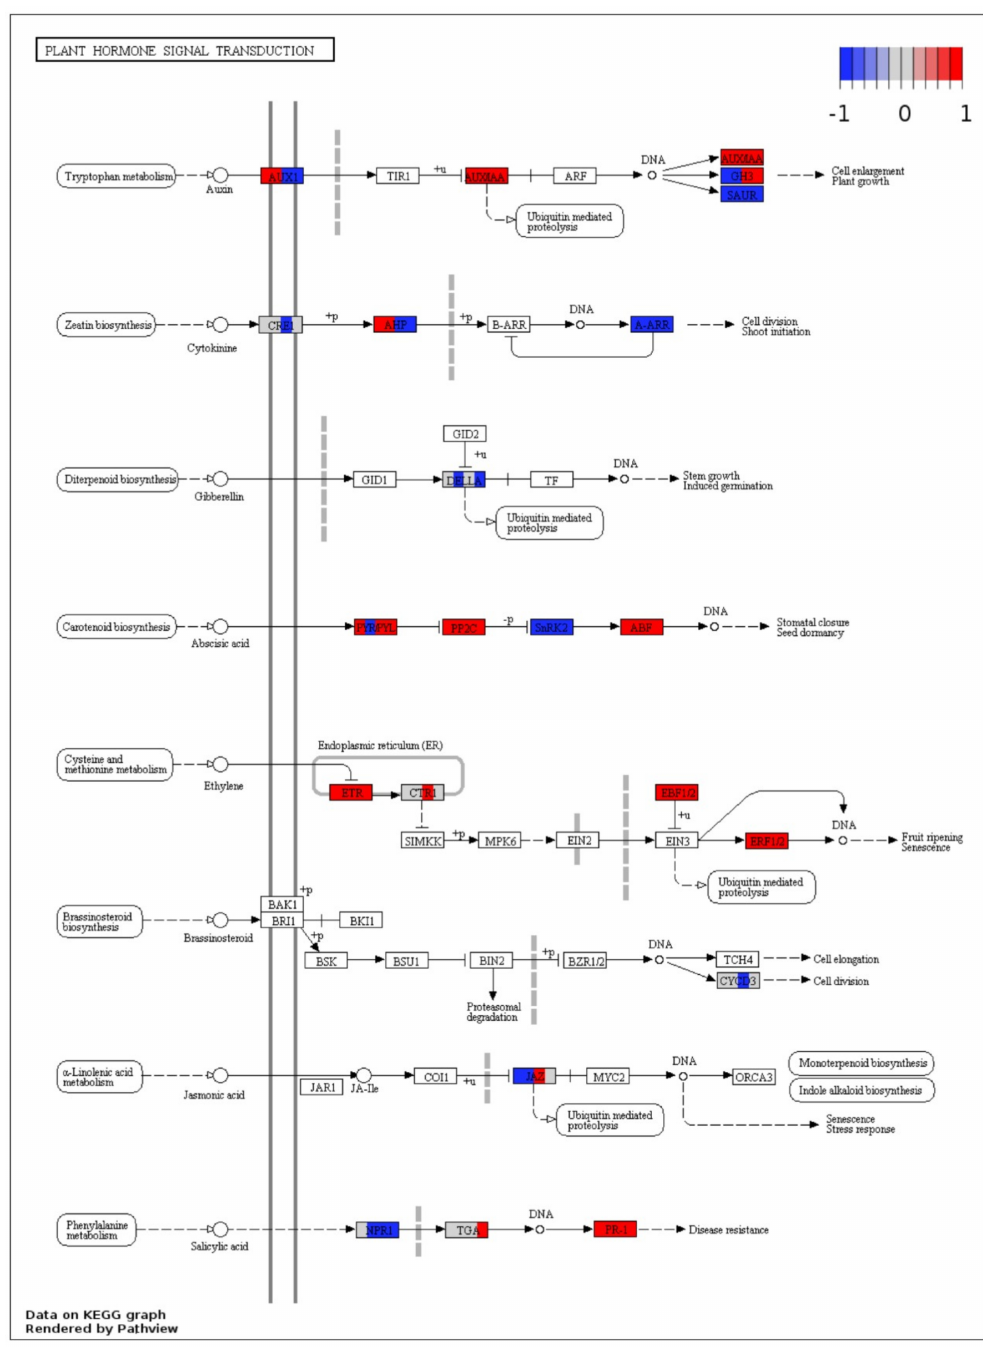
Figure 9. DEGs mapped on plant hormone signal transduction pathway. Each box depicts DEGs from four treatments vs. control comparisons thus divided into four segments, the left half represents Sp-R treatment vs. control with first segment (left) 24 hpi and second 48 hpi. The right half depicts Sp-S treatment vs. control with first segment (left) 24 hpi and second (right) 48 hpi. White box or no color fill means no DEG was assigned to that KO term. Color gradient represents log2 fold ratios with red representing upregulation and blue representing downregulation in treatments vs. mock samples. White segment in between colors means that term was not differentially expressed in the respective